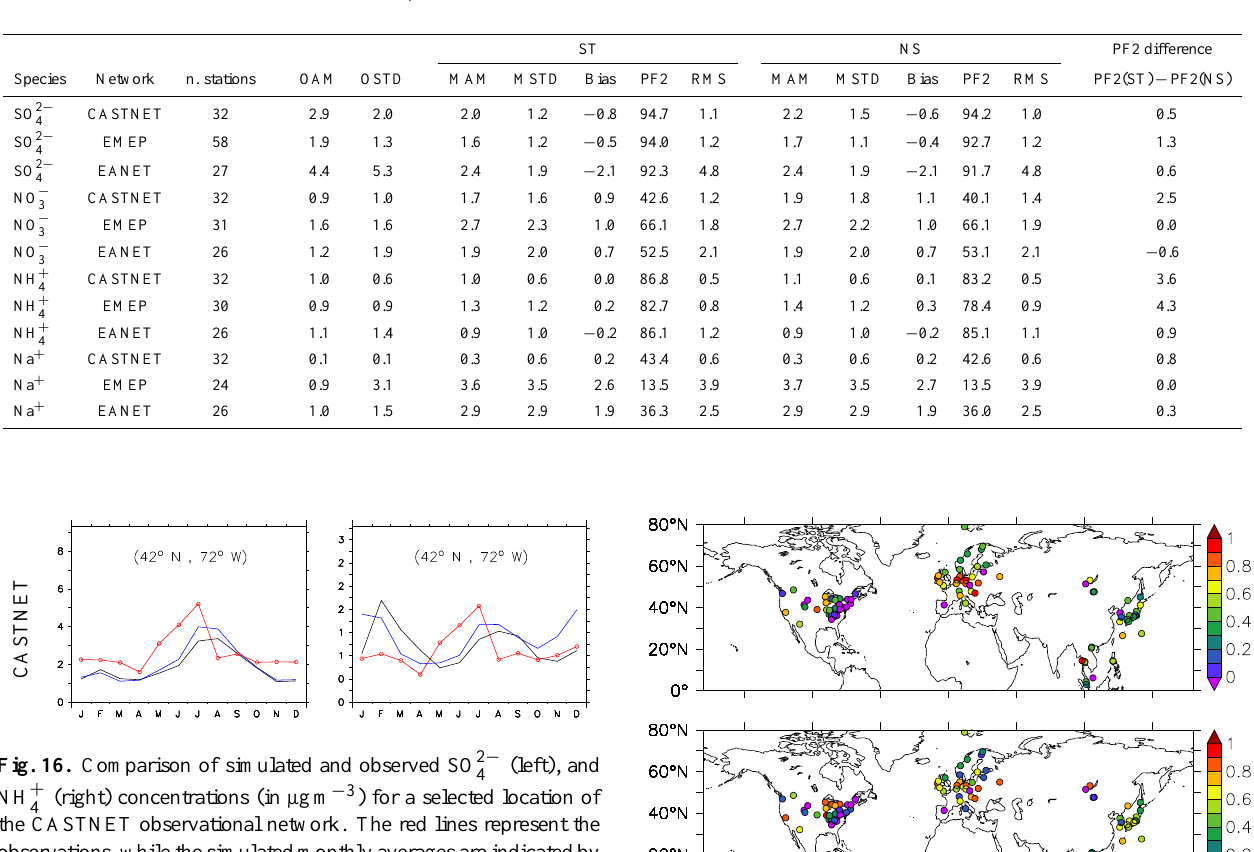
Table 6. Summary of the comparison of model results to observations of aerosol concentrations. OAM and MAM are the arithmetic mean of the observations and of the model, respectively (in µgm − 3 ), while OSTD and MSTD are the standard deviation of the observations and of the model, respectively (in µgm − 3 ). Bias represents the difference between MAM and OAM. MAM and MSTD were calculated sampling the model at the locations of the observations and monthly averaged as the observations, for the 2005–2008 period. MAM, OAM, MSTD and OSTD represents co-located measurements and model results. PF2 is the percentage of modelled point within a factor of two of the observations. RMS denotes the Root Mean Square error.